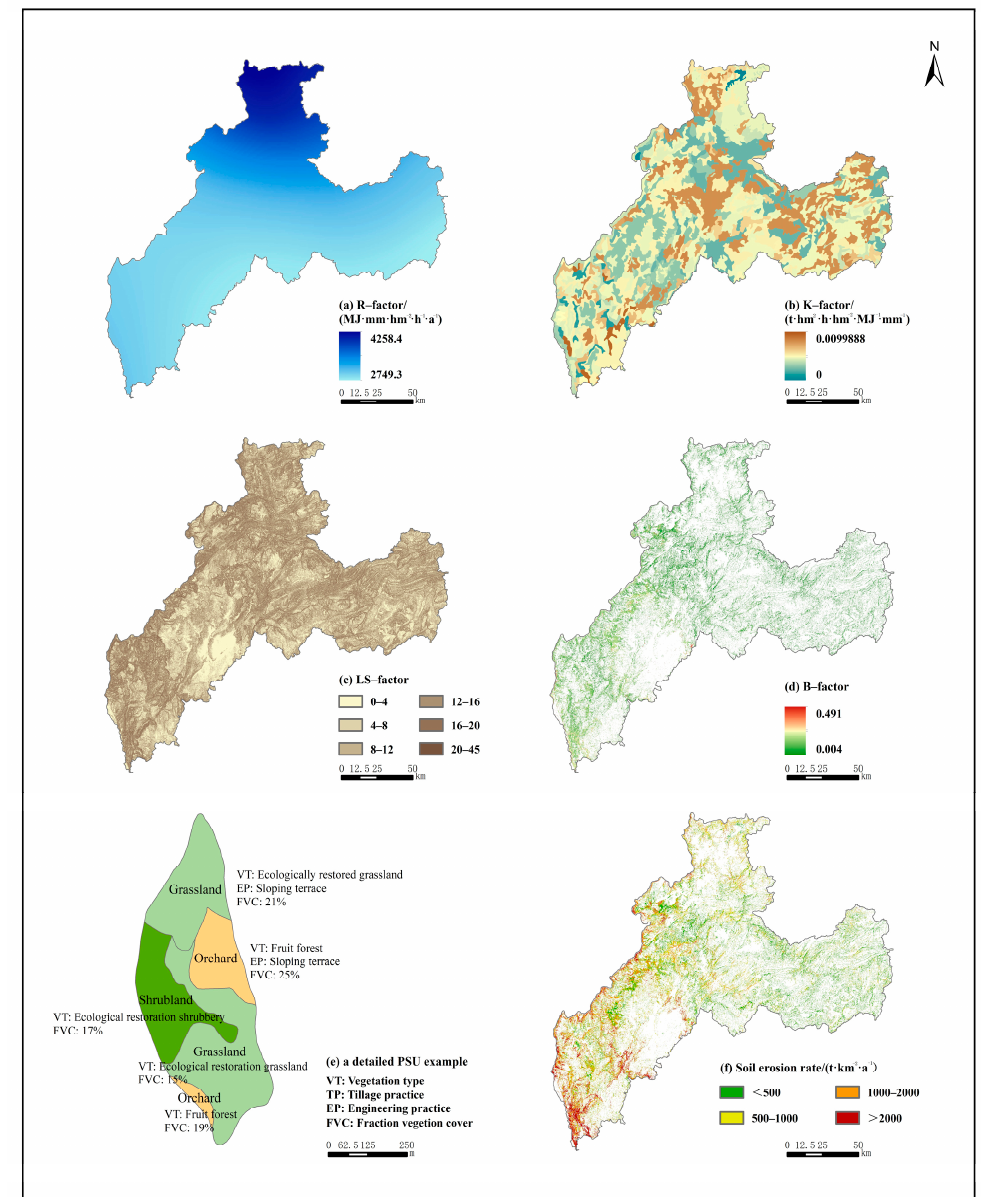
Figure 5. Quantification of grassland erosion in Zhaotong using the CSLE model: ( a ) Rainfall erosivity; ( b ) Soil erodibility; ( c ) Topographic factor; ( d ) Biological factor; ( e ) Example of field investigation units (PSUs) showing engineering and tillage measures; and ( f ) Annual average grassland erosion rate.